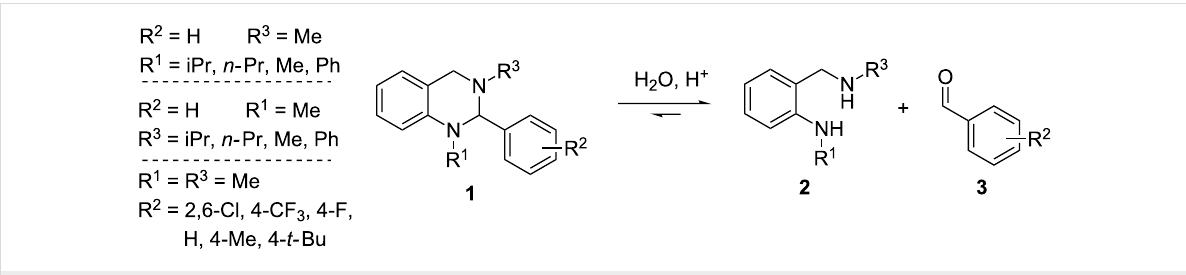
Figure 2: Hydrolysis of the aminal core of tetrahydroquinazolines 1 into the corresponding diamines 2 and aldehydes 3 .